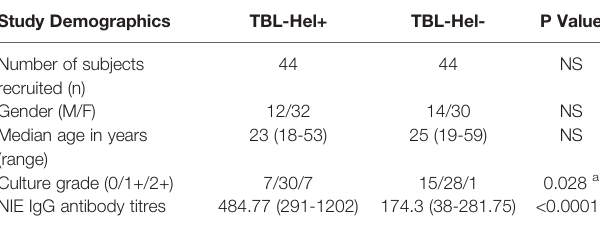
TABLE 1 | Demographics of the study population.